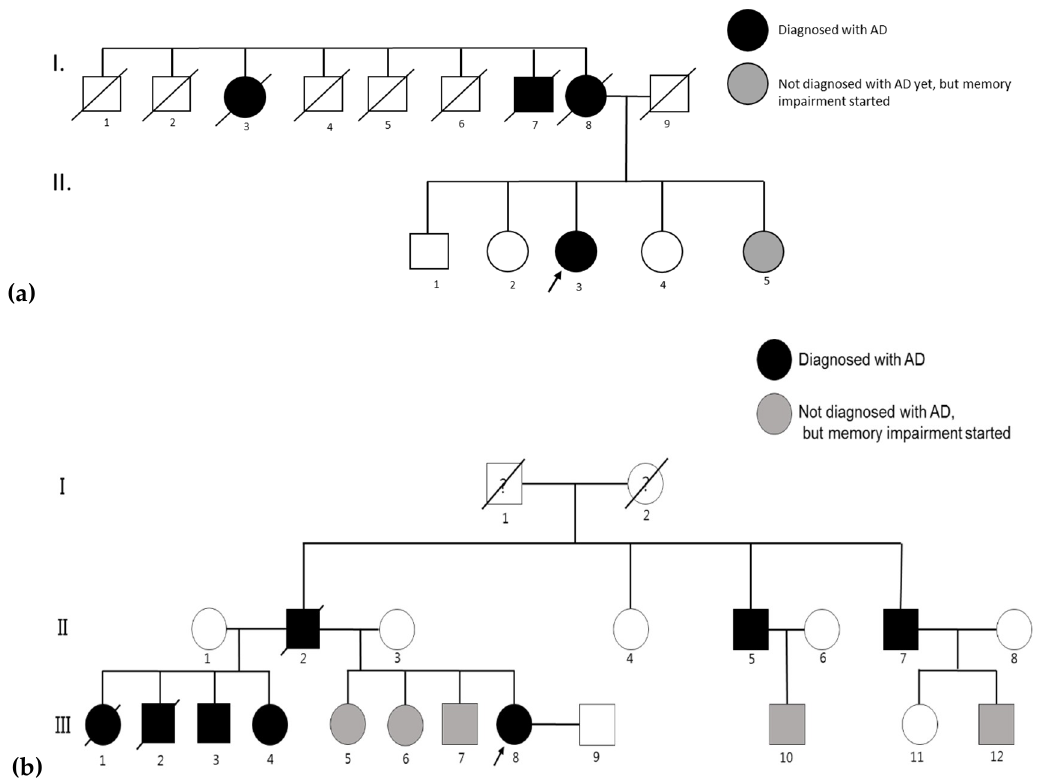
Figure 6. ( a ) Family tree of patient with PSEN1 T116I mutation (Family 1); and ( b ) family tree of patient with PSEN1 T116I mutation (Family 2). This figure was adapted and reprinted with the permission from Dove Medical Press (Clinical Interventions in Aging) [9]. White circles mean asymptomatic patients, which were not diagnosed with disease. Family members which were crossed out, already died. Arrows show the proband patient. Question mark at the grandparents means that their disease status is unclear.